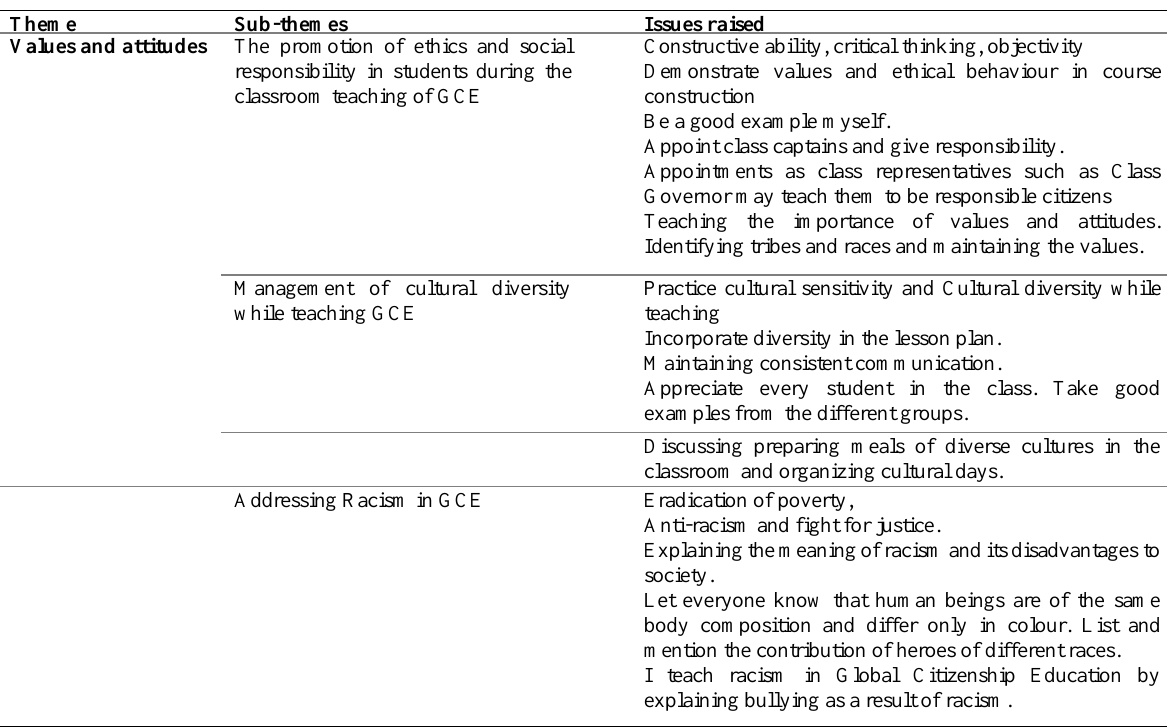
Table 6: Themes and sub-themes concerning the promotion of ethics and social responsibility in students during the